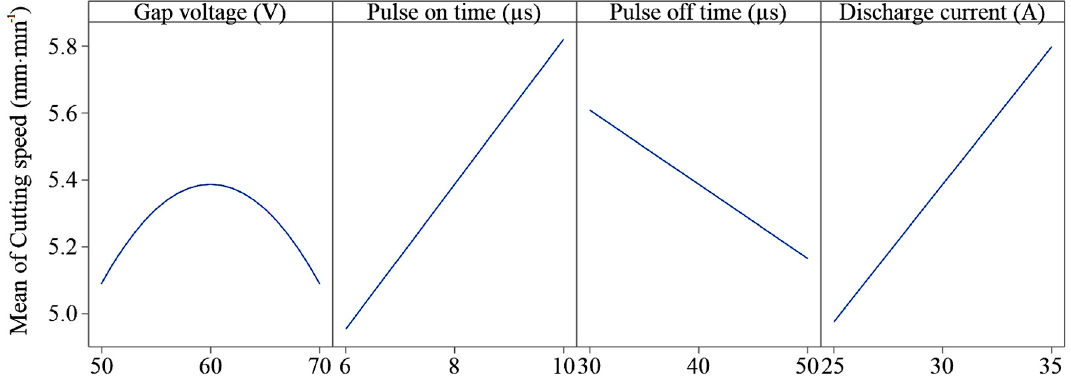
Figure 6. Main e ff ects plot for the mean of cutting speed. Figure 6. Main effects plot for the mean of cutting speed. Figure 6. Main effects plot for the mean of cutting speed.